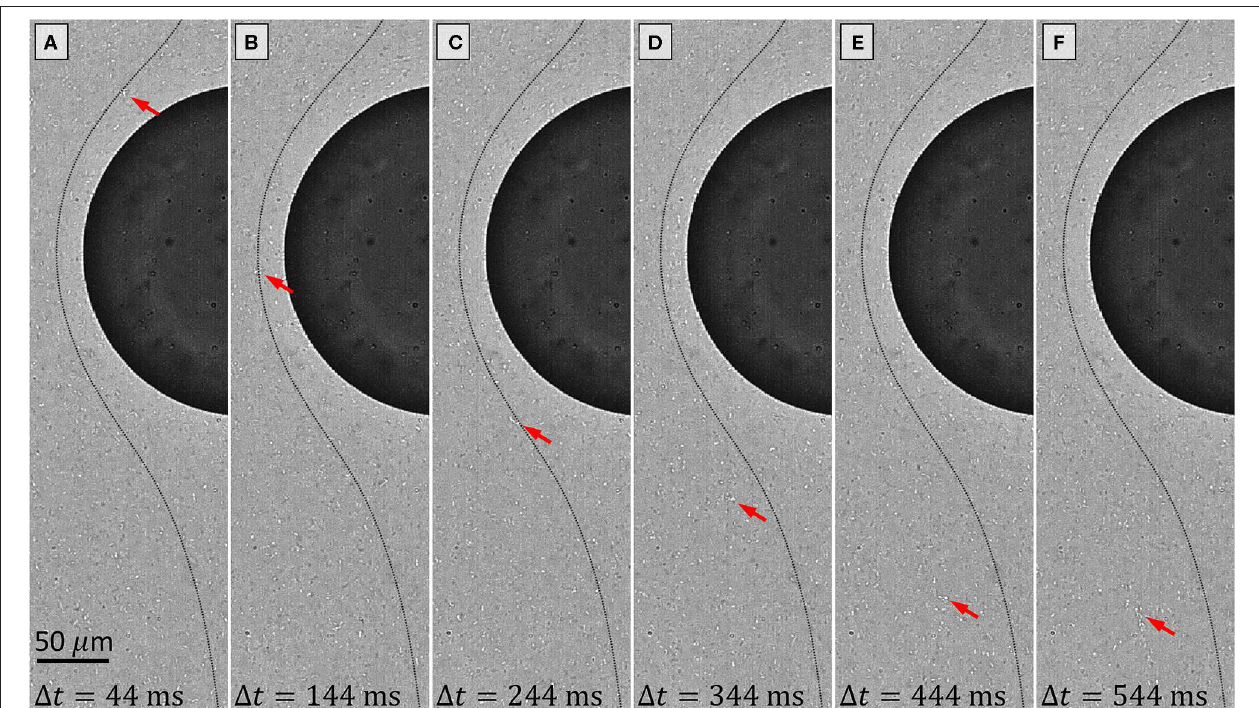
FIGURE 4 | Raw images of a high speed imaging sequence captured 50min after the first bacteria encounter are shown. The time step for each image during the 1s imaging sequence is shown at the bottom, and 100ms separates each image. A video of this sequence is provided in the Video S1 . In (A) a cluster of indicated by the red arrow. The thin dotted black line is a streamline of the mean flow passing through the current position of the indicated cluster. In (B) the cluster has traveled along the streamline. In (C) the cluster encounters a transparent EPS filament (confirmed in Video S1 ). In (D–F) the cluster has now deviated from the streamline and is trapped in the EPS